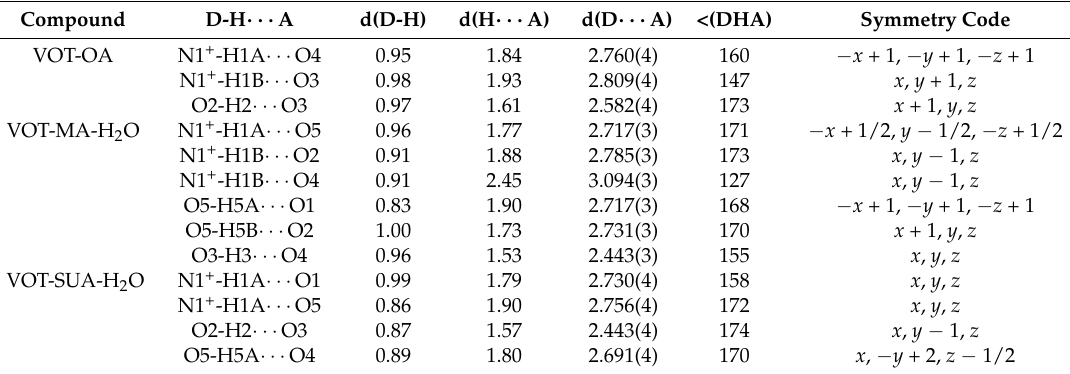
Table 2. Hydrogen bond distances (Å) and angles ( ◦ ) for three salt